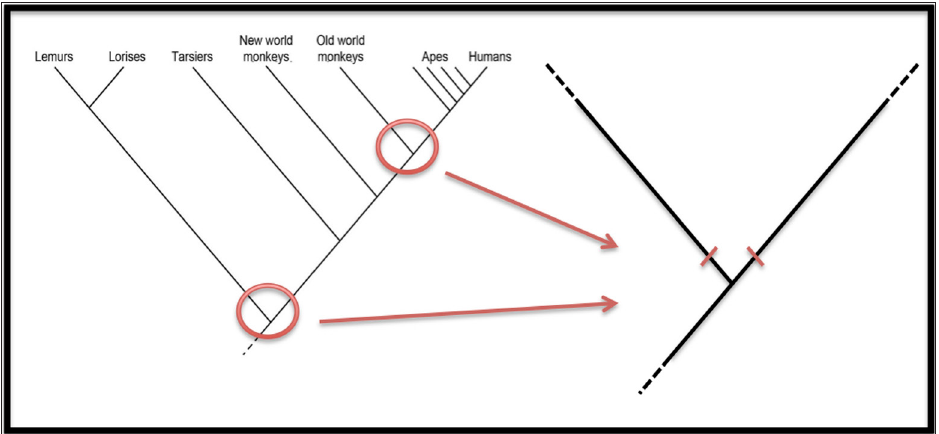
Figure 1: Diagram to illustrate Cartmill’s (2012) suggestion that the differentiation between two clades at any taxonomic level is due to the initial differentiation of two species. Immediately following cladogenesis, the two species are theoretically practically identical as they possess most of the same adaptations and probably inhabit similar environ- ments and therefore are subject to similar selective